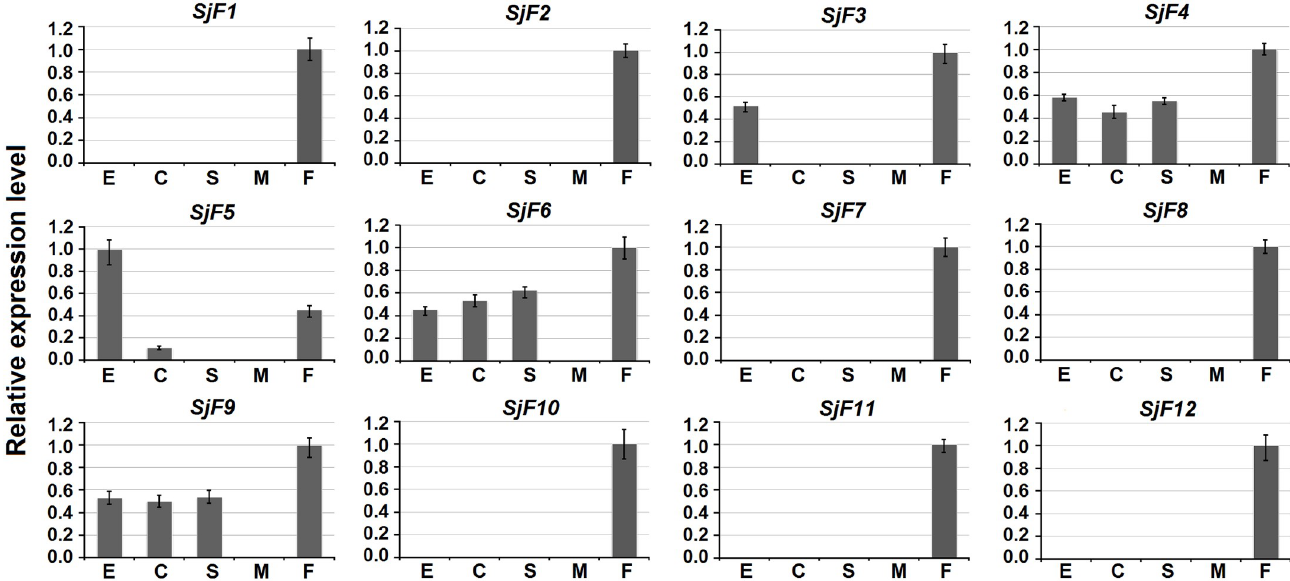
Fig 2. Expression patterns of 12 candidate genes in different developmental stages of S . japonicum . The expression levels of genes in four developmental stages (E, eggs; C, cercariae; S, hepatic schistosomula; M, adult male worms; F, adult female worms) were quantified by qPCR. The highest gene expression level in the four stages was set to 1. Error bars represent the standard deviation of three technical